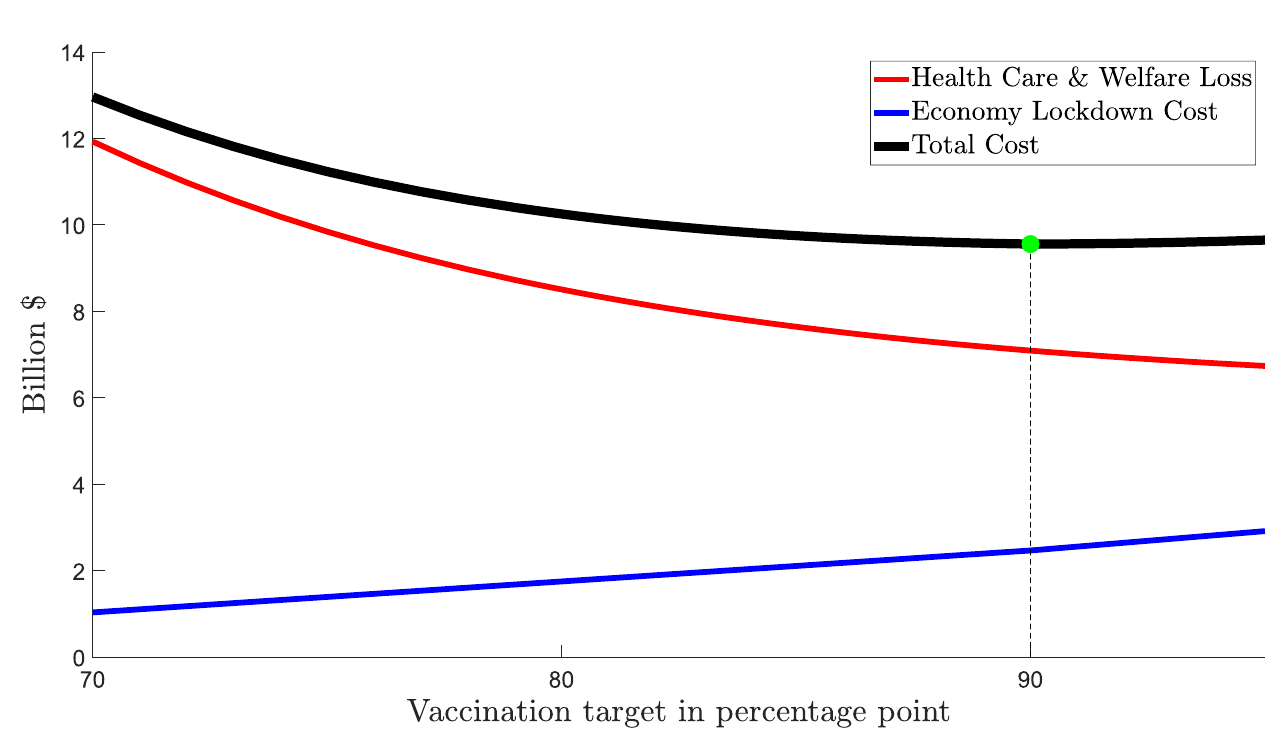
Fig 5. VIC: Societal costs of different lockdown ‘opening up’ vaccination rates. Notes about Fig 5: 1. All costs are counted from October 11 th 2021. 2. Total costs = health care costs and welfare losses + economy lockdown costs.